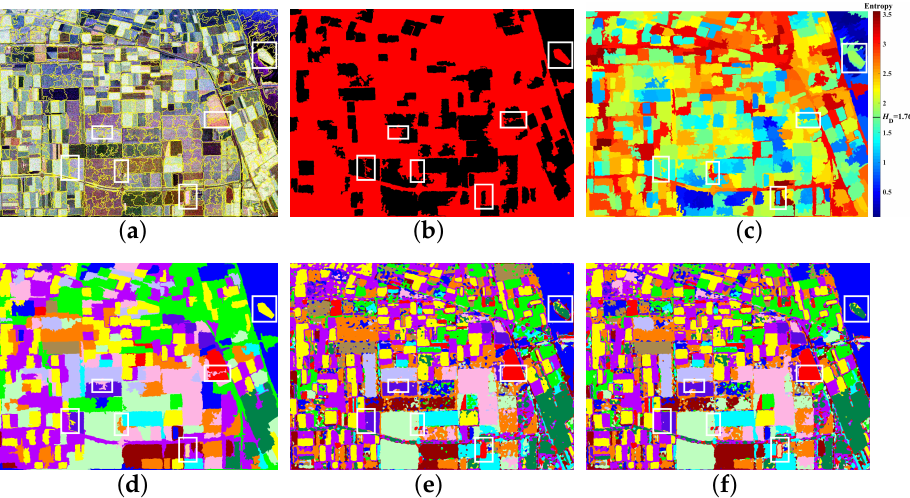
Figure 6. Performance of the superpixel entropy when k = 592, P m = 0.75, H D = 1.7631. ( a ) Superpixel on Pauli pseudo-color image. ( b ) Superpixel distinguished by SED. Red color represents superpixels reclassified using CV-CNN. ( c ) The heat map of superpixel entropy, which also reflects the degree of evidence conflict in the superpixel. ( d ) The full image result of LGBM+SLIC. ( e ) The full image result of CV-CNN. ( f ) The full-image result of our proposed